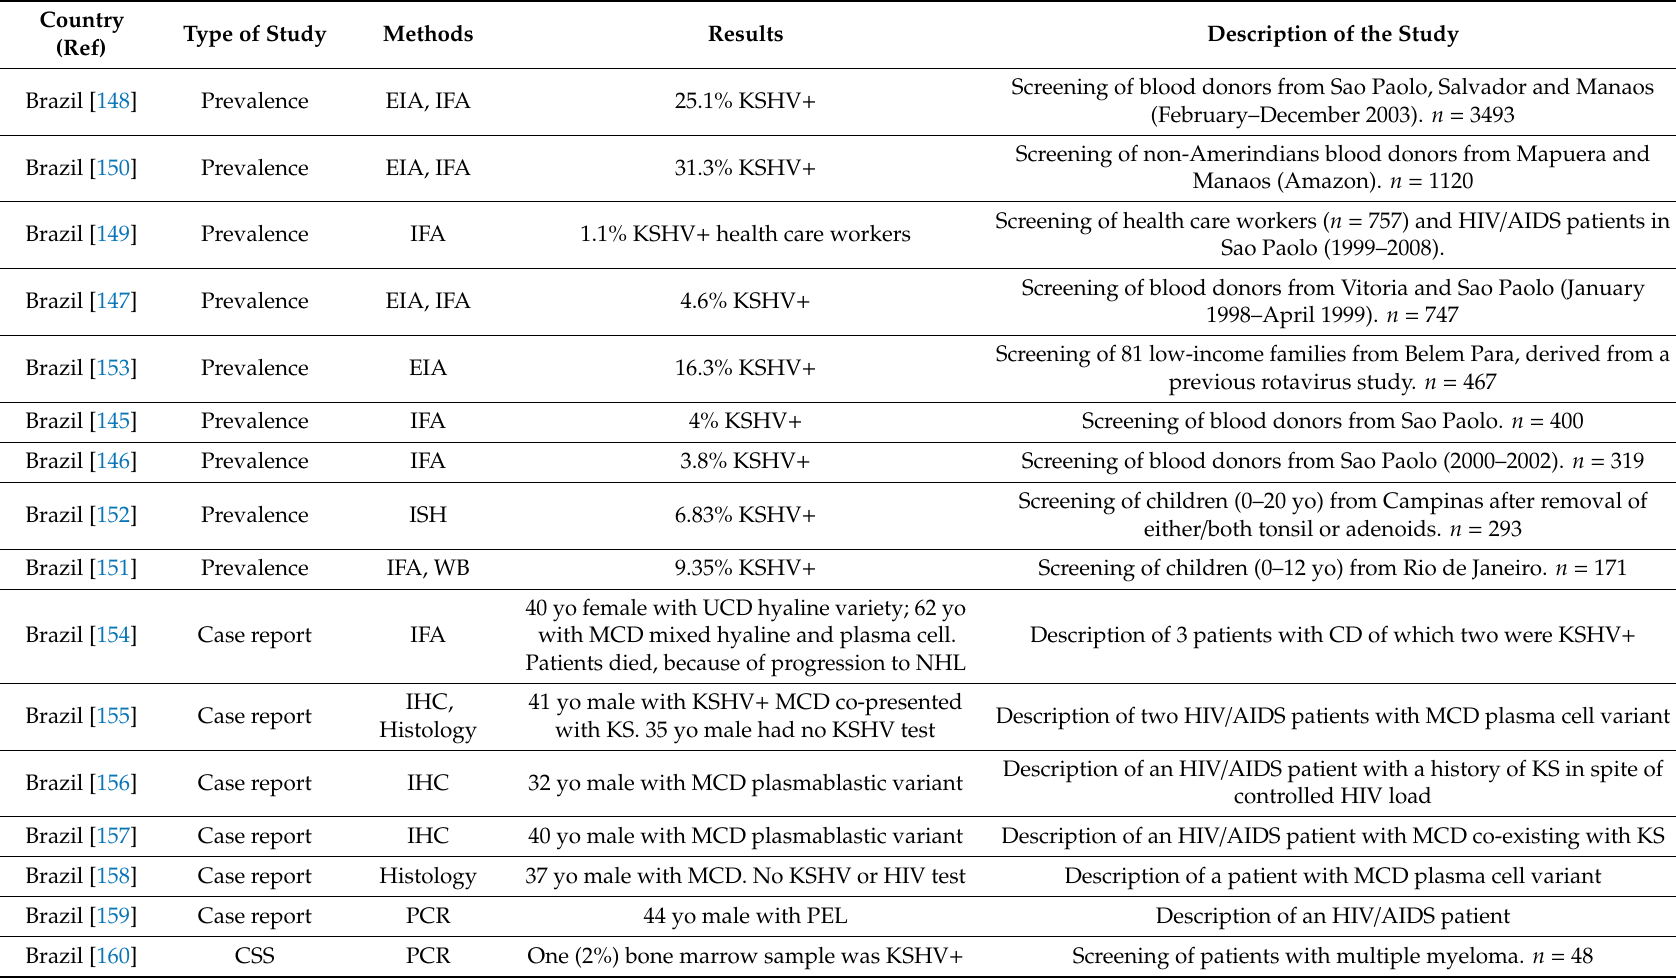
Table 2. Summary of studies about